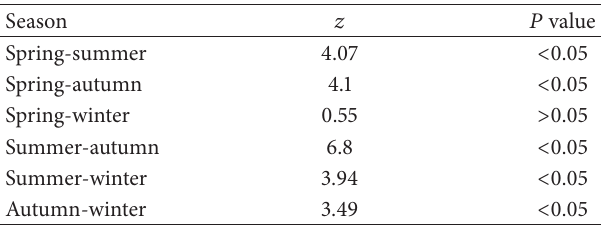
Table 1: Pairwise comparisons between seasonal values of the mean vacuity index (VI) using 𝑧 .